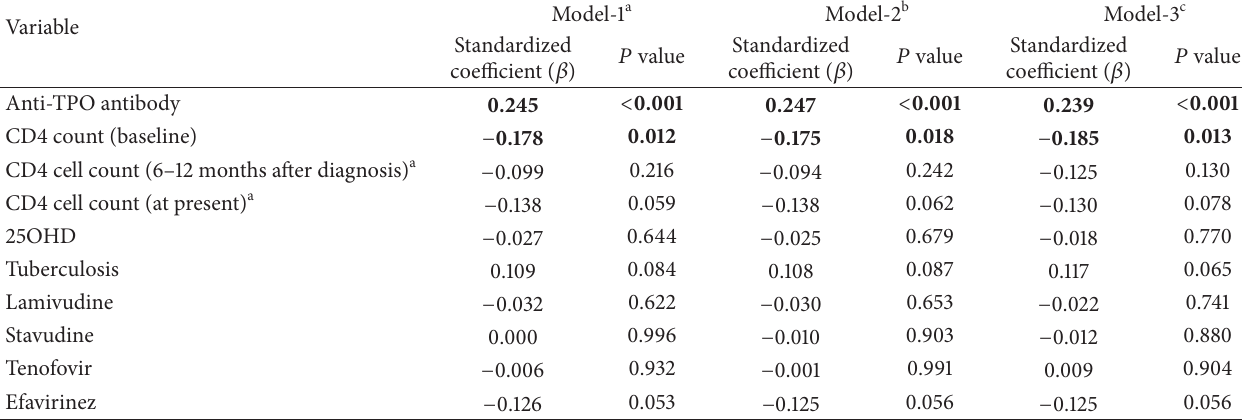
Table 4: Regression analysis showing parameters that are predictors of subclinical hypothyroidism in patients with HIV infection. Variable Anti-TPO